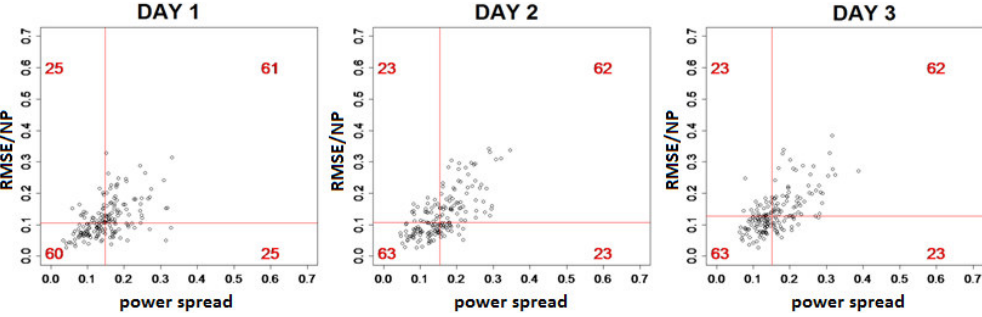
Figure 3. ECMWF deterministic power forecast error (RMSE / NP) vs. ensemble power spread computed as a daily average for three lead times. EPS T639 / T319 (32km). The lines are plotted on the statistical median. The red numbers indicate the points inside each quadrant (Day 1, 2 and 3 interval are explained in Table 2 caption).